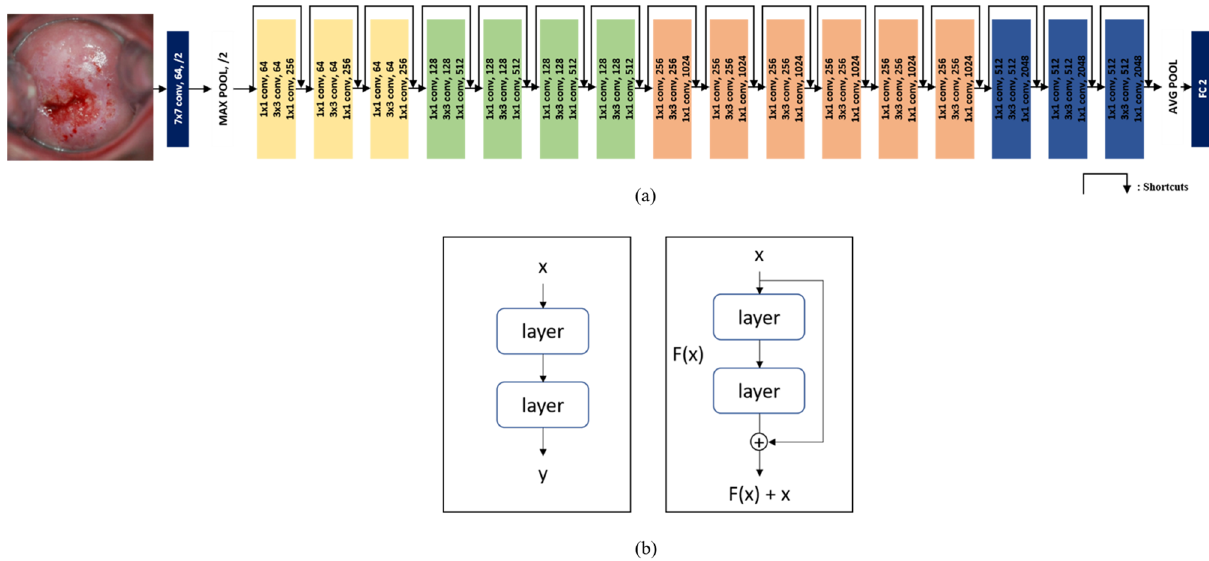
Figure 4. ( a ) ResNet50 Architecture of DL, reducing the dimension by adding a 1 × 1 conv to each layer, the amount of computation is reduced and the training speed is accelerated. ( b ) learning method of existing CNN (left) and ResNet (right). By adding shortcuts that add input values to output values every two layers, errors are reduced faster than with existing